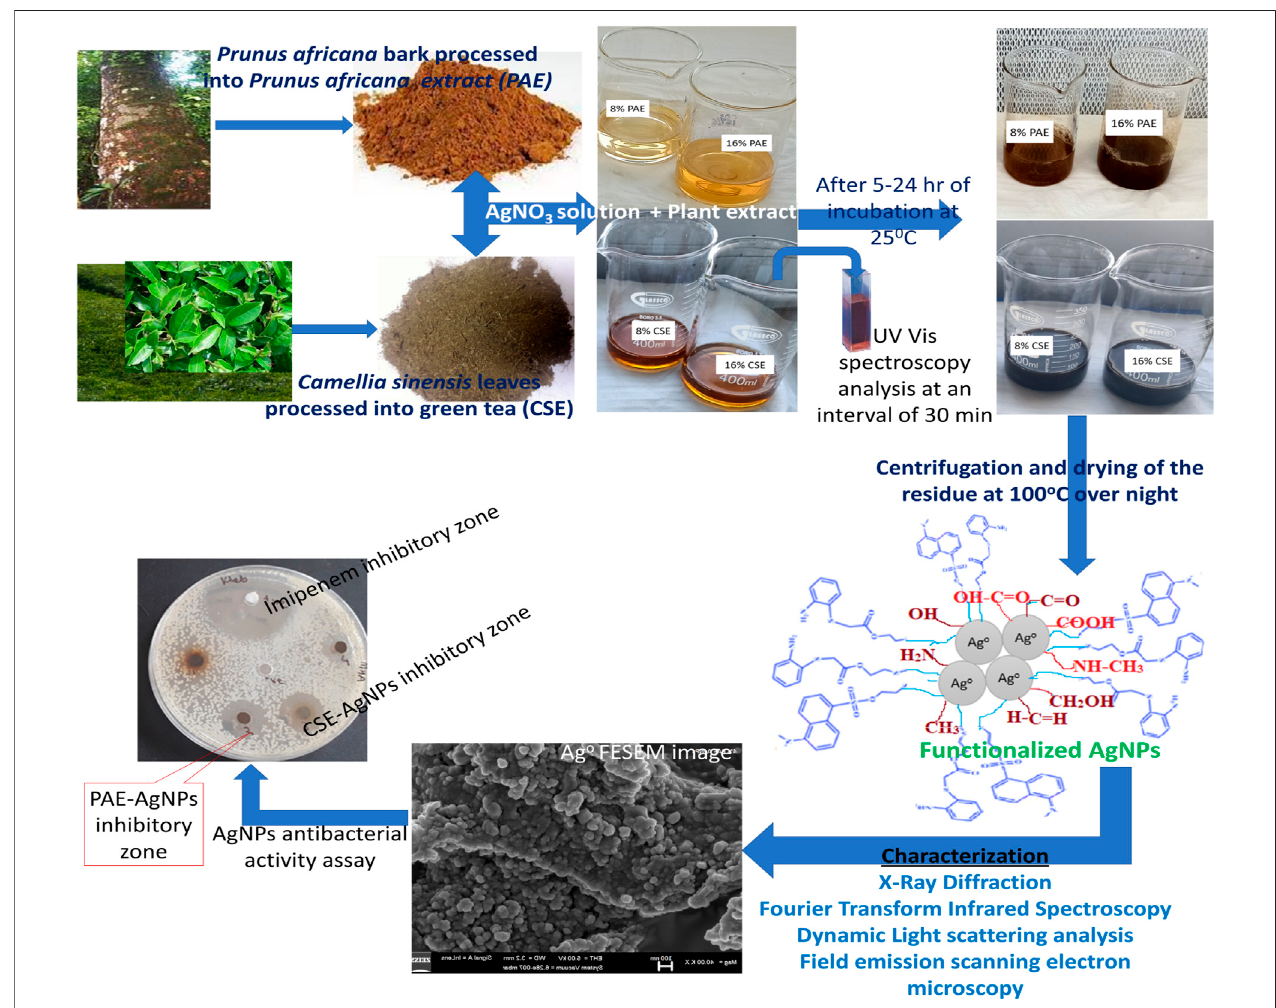
FIGURE 2 | Schematic presentation for biosynthesis, characterization, and antibacterial assay of silver nanoparticles.